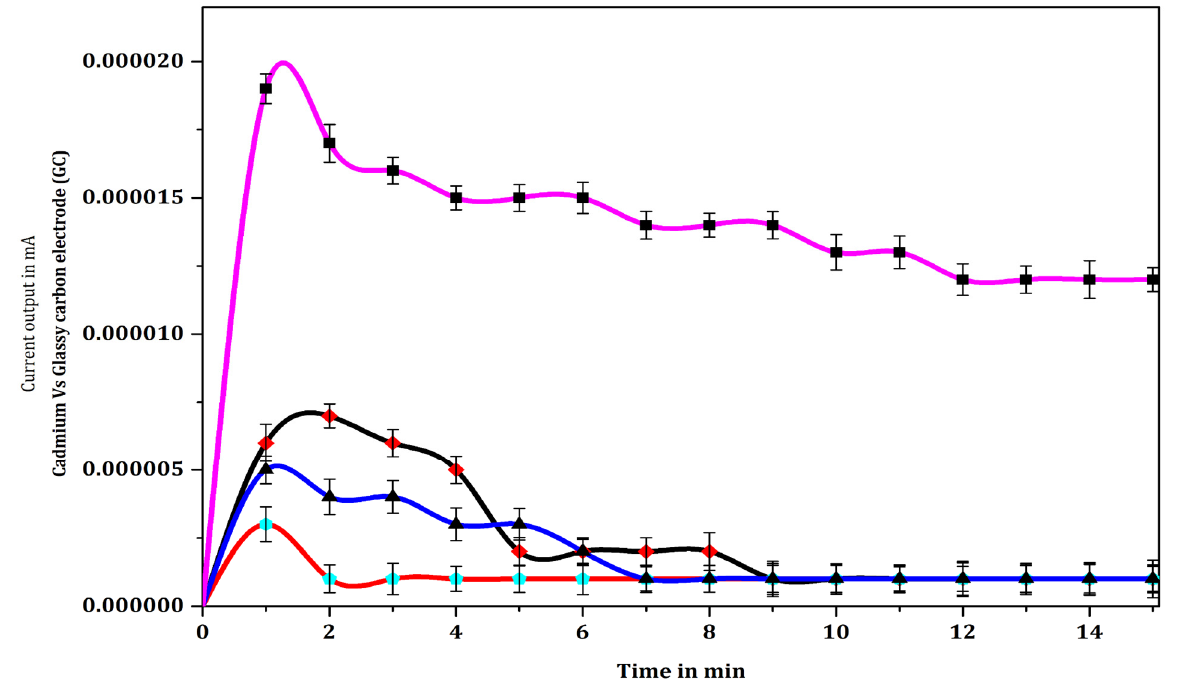
Figure 12. Response signal output current curves derived from the glassy carbon electrode with immobilized specific mouse anti- Salmonella monoclonal antibody (MCA) (1:30,000 dilution) in the presence of 30 specific cells of Salmonella sp. (10 µL of 3 × 10 3 cells/mL, ) and non-specific cells such as 30 cells of Vibrio sp. (3 × 10 3 cells/mL, ), 30 cells of Pseudomonas sp. (3 × 10 3 cells/mL, ) and 30 cells of Streptococcus sp. (3 × 10 3 cells/mL, ) with enzyme and substrate complex. Data represent mean ± SD (n = 5). Table 5. Sensitivity analysis of sensor among various test samples. p -value for each pair of data analyses using one-way ANOVA. The significance value (0. 1) provided in parenthesis beside the p -value denotes the significance for each pair of data. Significance value 1 indicates that the data pairs are significantly different ( p -value lesser than 0.05). The significance value 0 depicts that the data pairs are not significantly different ( p -value greater than 0.05). Non-Specific Vibrio sp. Specific Salmonella sp. Non-Specific Pseudomonas Non-Specific Strepto- sp. coccus sp. - 0.39087 (0) 0.9147 (0) 0 (1) Non-Specific Vibrio sp. Specific Salmonella sp. sp. coccus sp. - 0.78309 (0) 0 (1)